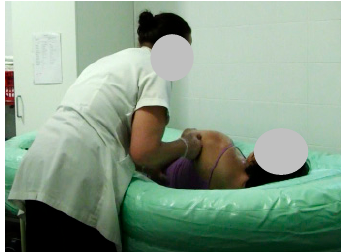
Figure 8. Step 1: Beginning of the filling process.